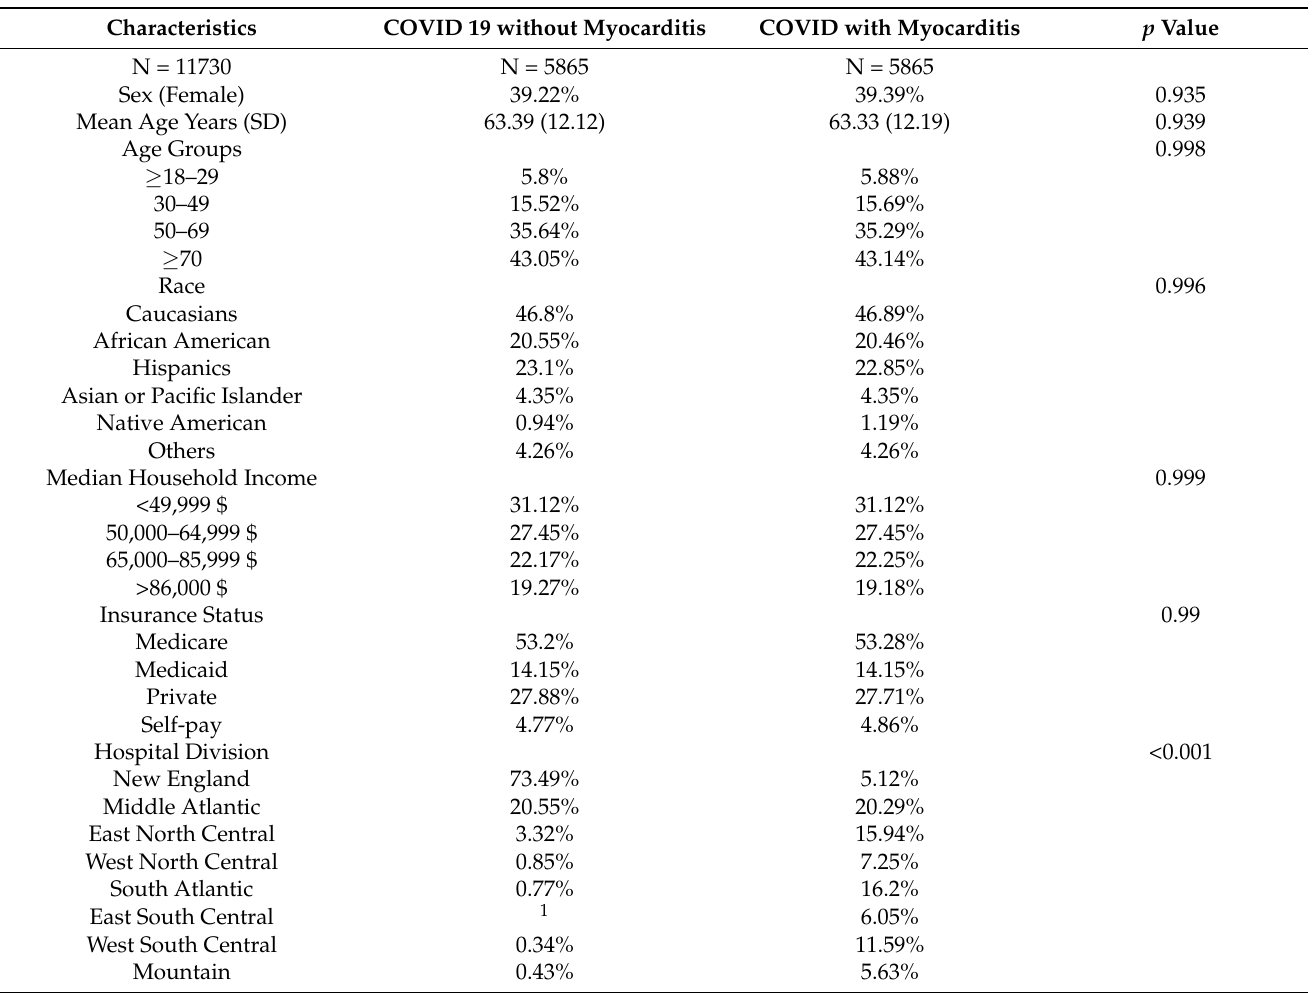
Table 2. COVID-19 Propensity 1:1 Matched patient-level Characteristics 2